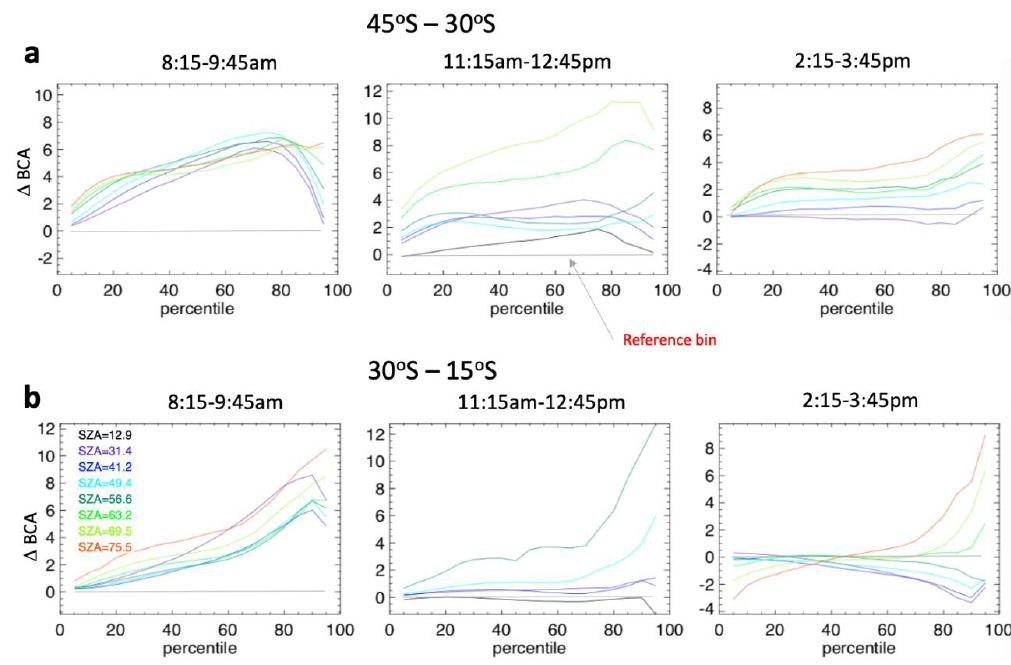
Figure 5. The diurnal adjustment (∆BCA diurnal ) for clouds in the ocean morning-peaking geographic bin for two latitude bands ( a ) 45°S to 30°S and ( b ) 30°S to 15°S, as function of the percentile of the observed BCA.